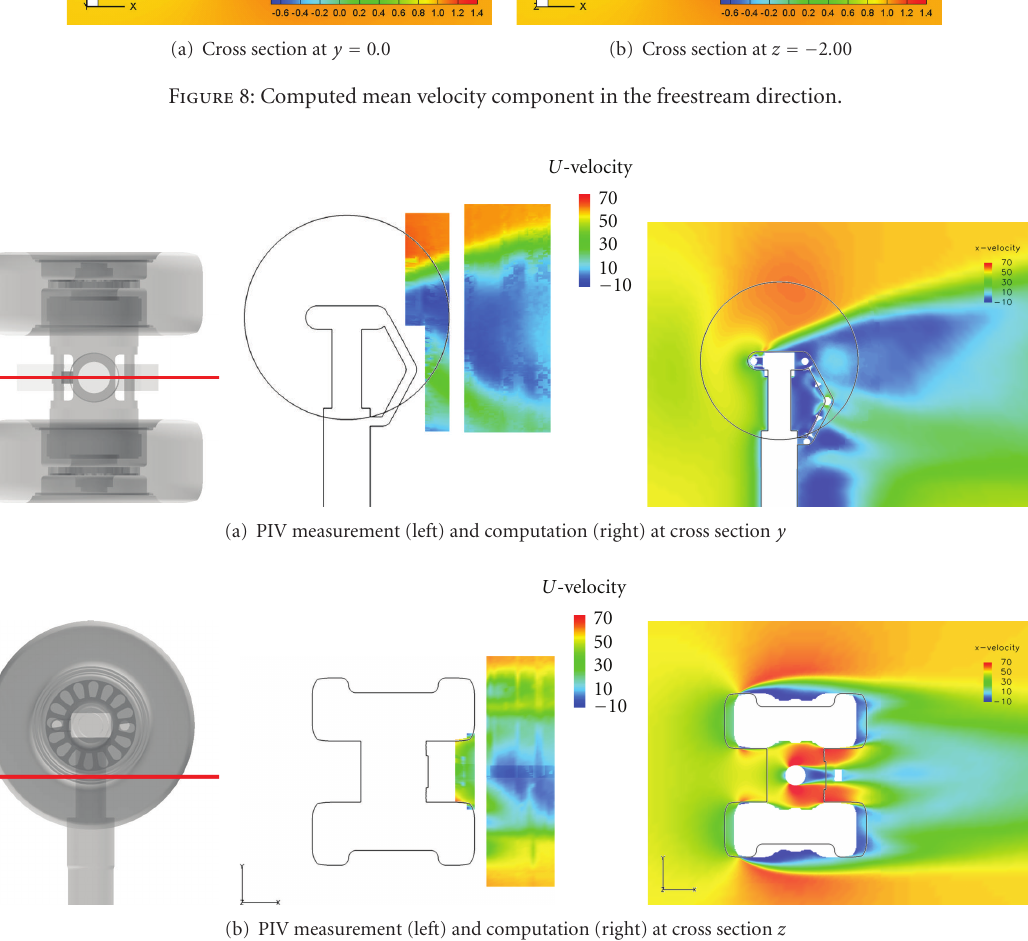
Figure 9: Mean velocity component in the freestream direction by Murayama et al.